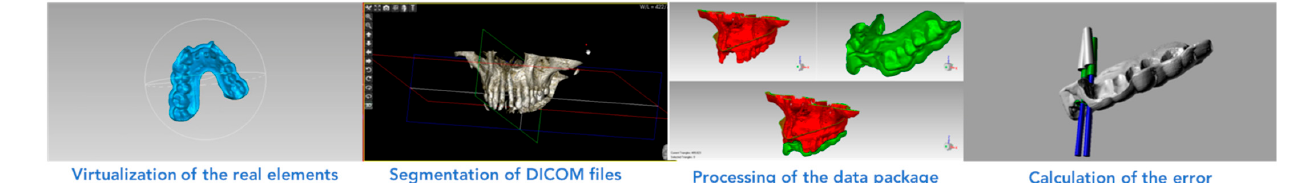
Figure 1. Schematic representation of superimposition’s steps.